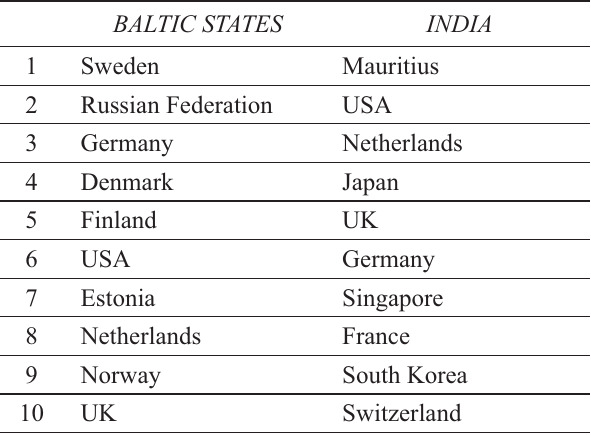
Table 1. Main investing countries BALTIC STATES